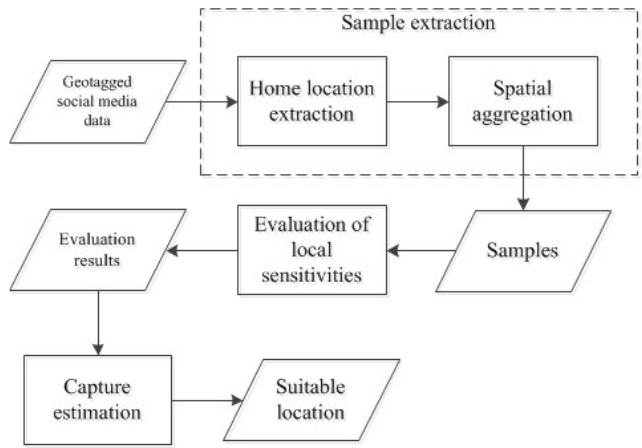
Figure 2. Framework for using social media data to solve competitive location problems.